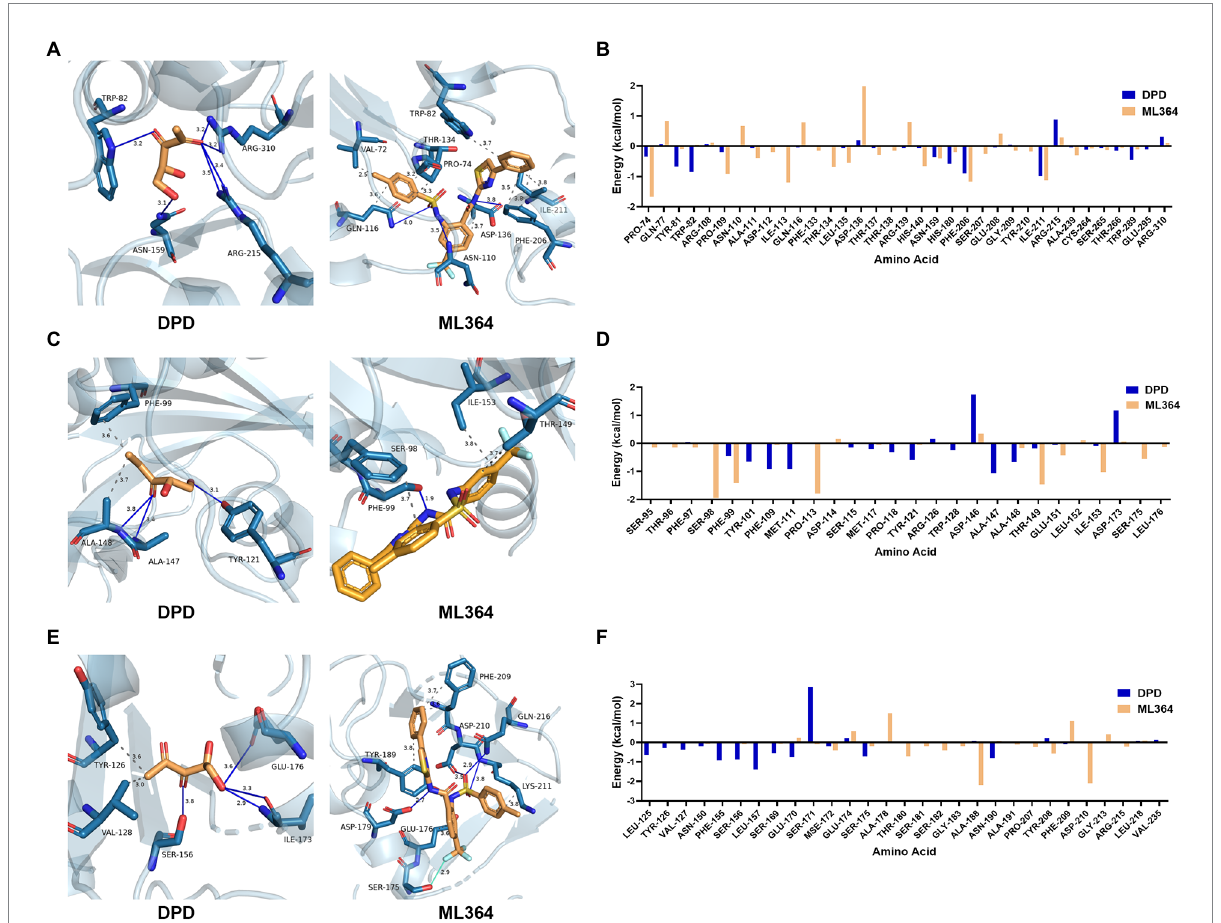
FIGURE 4 The interactions and per-residue free energy decomposition between DPD or ML364 with DPD/AI-2 receptors. (A) The interactions between DPD or ML364 with LuxP protein of V. Campbellii . (B) The per-residue energy decomposition between LuxP with DPD or ML364. (C) The interactions between DPD or ML364 with PctA protein of Pseudomonas aeruginosa . (D) The per-residue energy decomposition between PctA with DPD or ML364. (E) The interactions between DPD or ML364 with TlpQ protein of P. aeruginosa . (F) The per-residue energy decomposition between TlpQ with DPD or ML364. Protein-ligand interactions are colored as following: blue solid line, hydrogen bond; dash line, hydrophobic interaction; cyan solid line, halogen